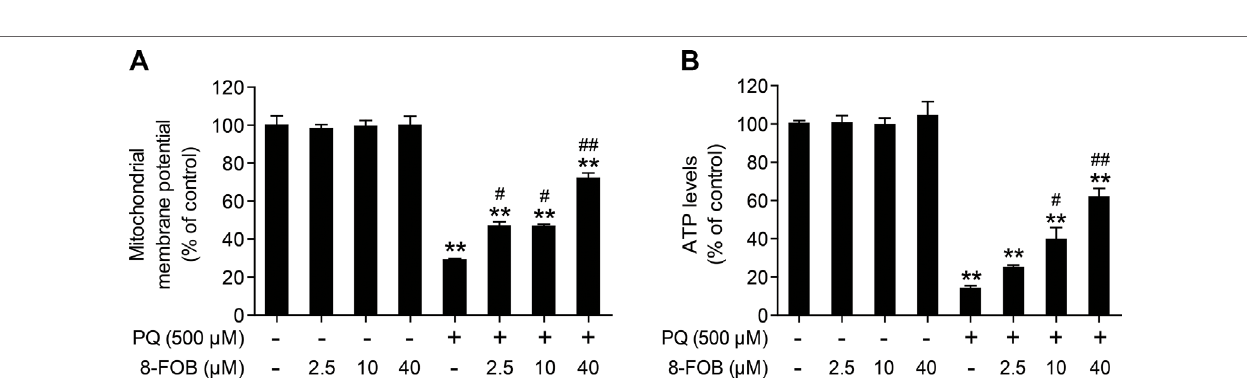
FIgURe 4 | 8-Formylophiopogonanone B (8-FOB) alleviates paraquat (PQ)-induced mitochondrial dysfunction in L02 cells. (A) The mitochondrial membrane potential (Δ Ψ m) of L02 cells was measured 24 h after PQ treatment. (B) Measurement of ATP levels after 24 h of PQ treatment. The values are presented as the means ± SEM ( n = 6). ** p < 0.01 vs the control group; # p < 0.05, ## p < 0.01 vs the PQ group.